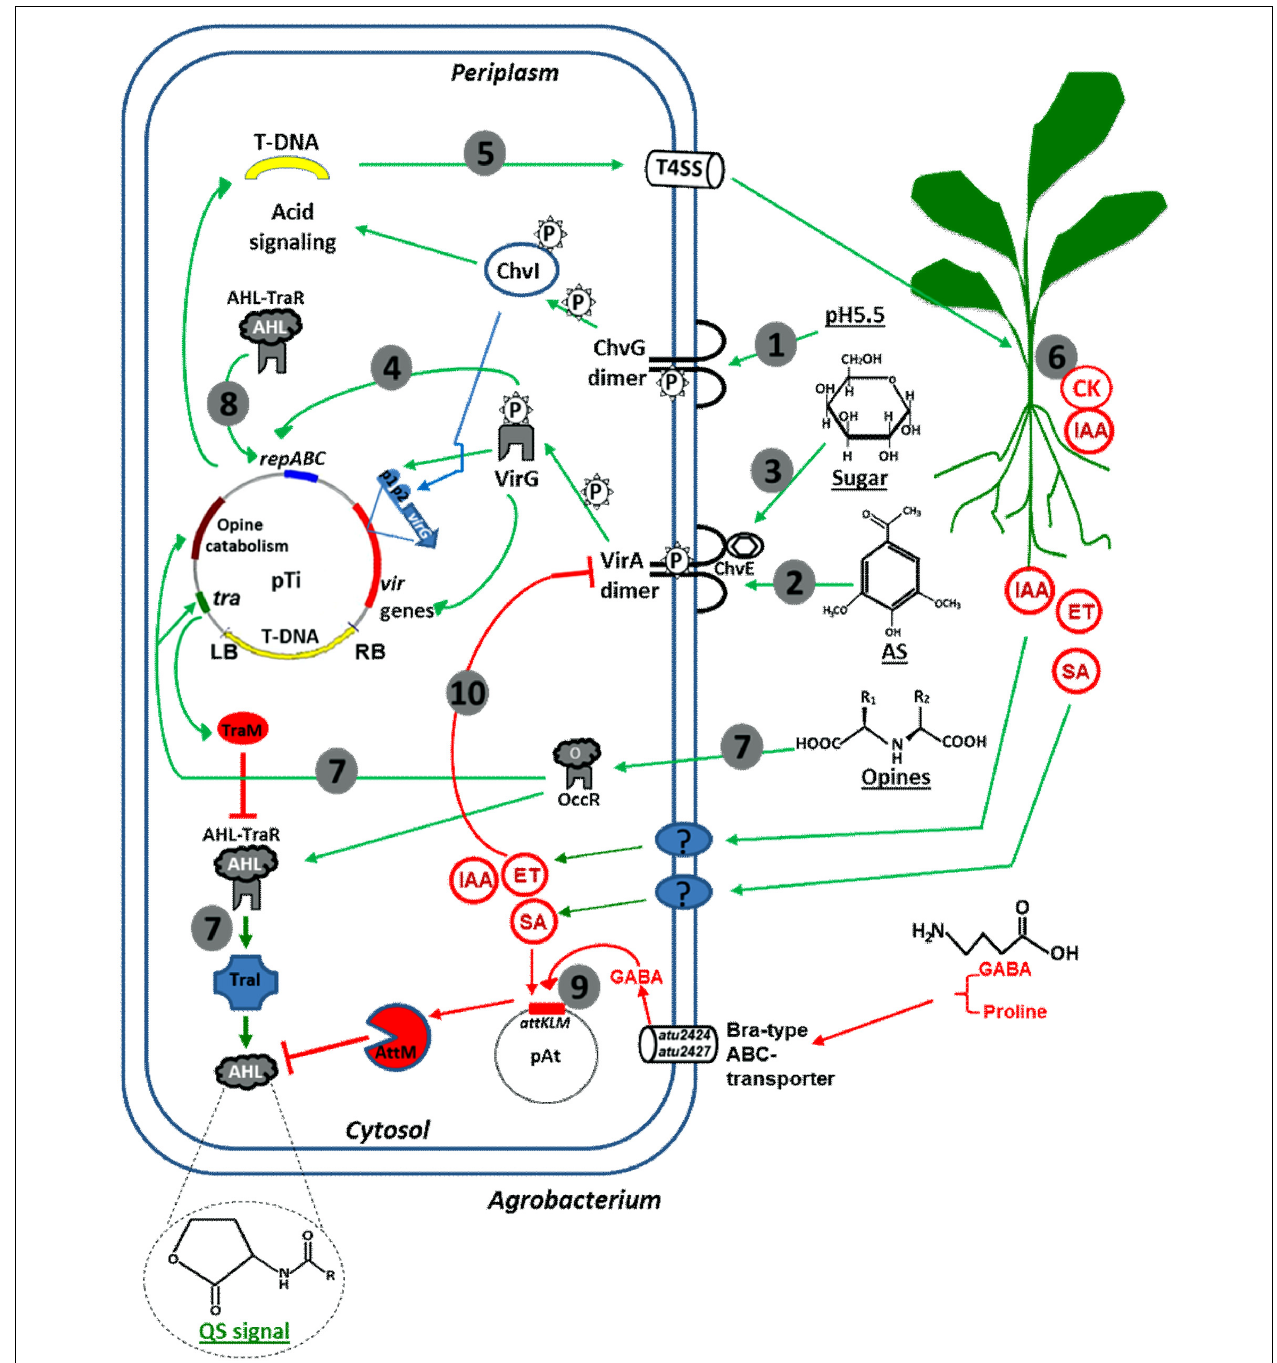
process and deliver T-DNA into plant nuclei; (6) Expression of T-DNA encoded genes in plants leads to the production of IAA, CK, and opines; (7) Opine activates Agrobacterium genes for opine metabolism, as well as TraR/TraI QS system that subsequently induces Ti plasmid conjugation; (8) QS also up-regulates Ti plasmid copy number for maximal pathogenicity; (9) Agrobacterium quorum quenching ( attKLM operon) is activated by plant-derived GABA and SA thereby down-regulates QS; (10) Agrobacterium hijacks plant-derived SA, IAA, and ET to down-regulate vir gene